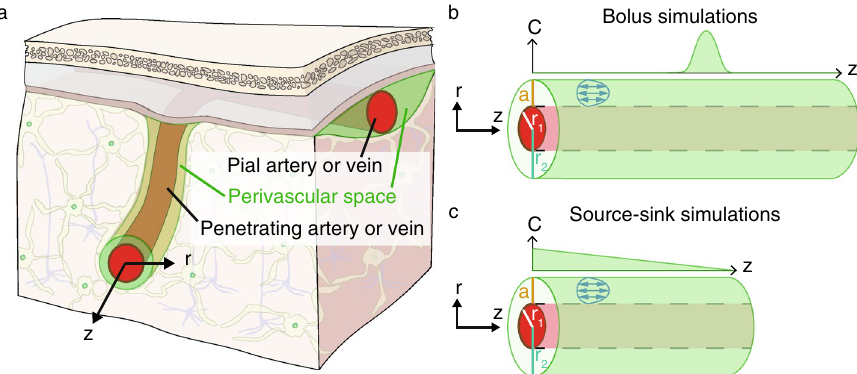
Figure 1. ( a ) A diagram depicting pial and penetrating arteries/veins in the brain and their surrounding perivascular spaces. ( b , c ) The idealized model (a concentric circular annular tube) of a penetrating perivascular space used in the simulations. Simulations are performed for a radial slice, on which the velocity field of a pulsatile flow with a net flow in the positive z -direction is depicted (blue arrows). The top plots in each panel are sketches of possible evolved solute concentration profiles corresponding to ( b ) bolus simulations and ( c ) source- sink